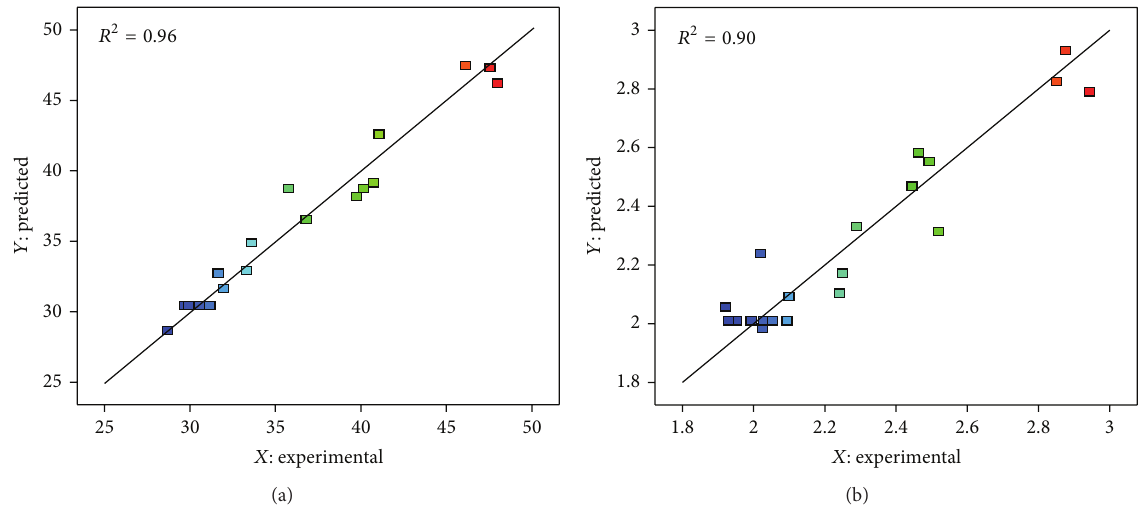
Figure 3: Correlation of predicted response versus experimental response: (a) tensile strength and (b) impact